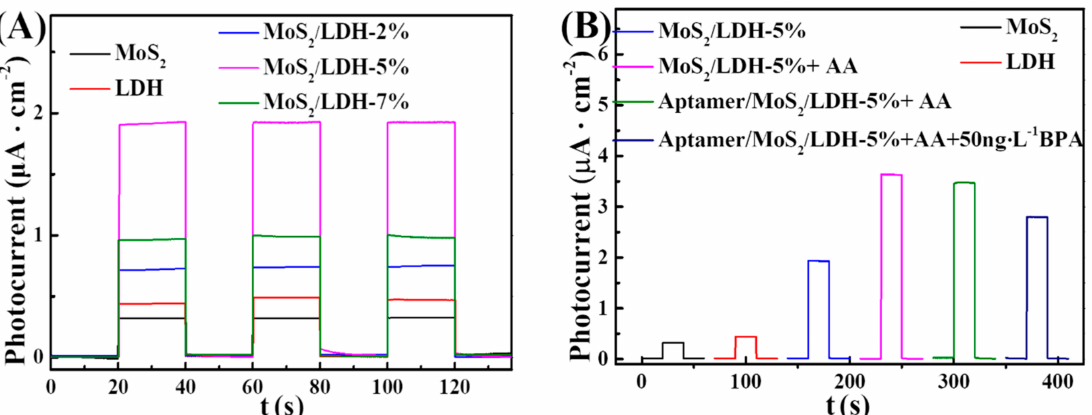
Figure 5. ( A ) Photocurrent outputs of a variety of electrodes. ( B ) Photocurrent outputs of a variety of electrodes for BPA detection at 0.1 V vs. SCE before and after introducing AA in PBS.